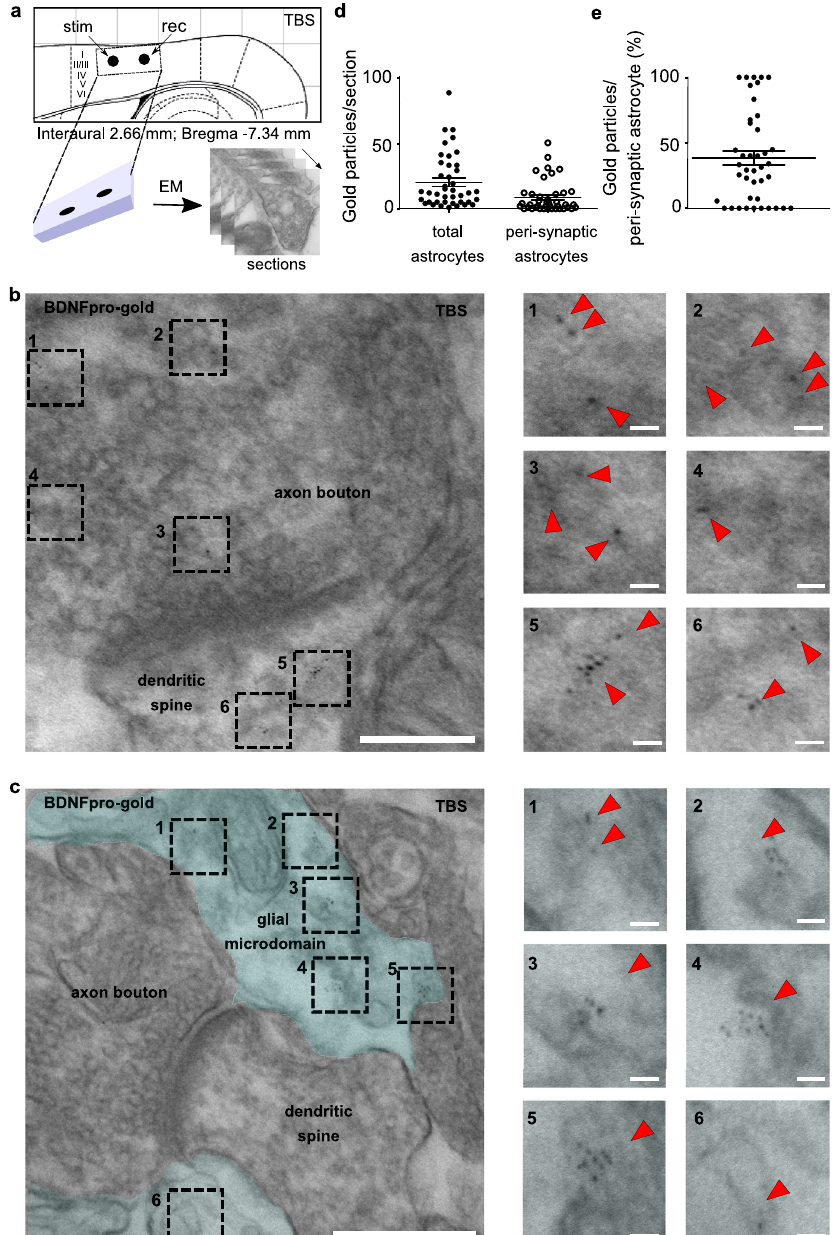
Fig. 3 localization of BDNFpro in astrocytic microdomains. a Experimental design linking fi eld-potential with electron microscopy (EM) in layer II/III perirhinal cortex. TBS (10 min)-slices were dissected for EM processing. b Representative EM-image depicts BDNFpro-gold particles at axon bouton (dashed squares 1 to 4) and dendritic spine (dashed squares 5 and 6). Scale bar: 100 nm. Magni fi cation indicates representative areas (dashed squares 1 to 6) in which gold particles (red arrowheads) localization is shown. Scale bars: 10nm. c Representative EM-image depicts BDNFpro-gold particles (dashed squares 1 to 6) at astrocytic microdomains (light blue) Scale bar: 250nm. Magni fi cation indicates representative areas (dashed squares 1 to 6) in which gold particles (red arrowheads) localization is shown. Scale bars: 20nm. d Dot plot depicts the number of BDNFpro-gold particles in whole astrocytes and peri-synaptic astrocytes counted per section ( n = 41 sections, 5 slices, 3 mice). e Dot plot depicts the percentage of BDNFpro-gold particles at peri-synaptic astrocytes ( n = 41 sections, 5 slices, 3 mice). Data are